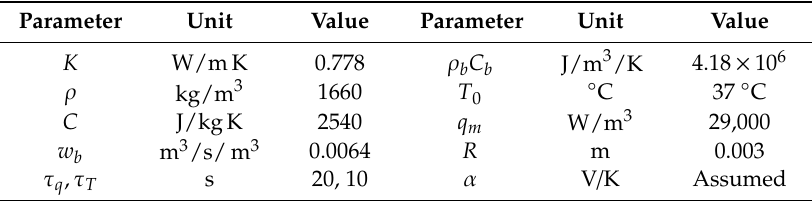
Table 1. Properties of tumor tissue